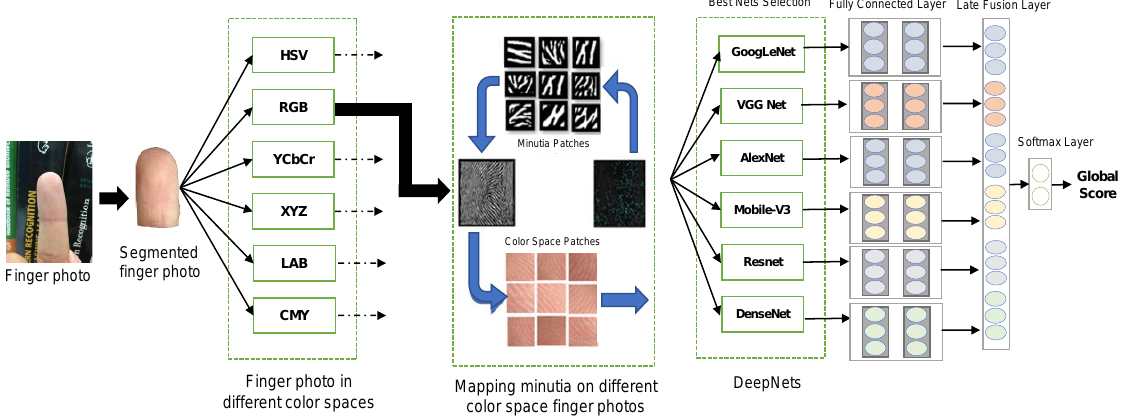
Figure 3. The finger photo is segmented with respect to the distal phalange and transformed to different color spaces. Patches centered around minutiae points are determined and used to feed different CNNs. Deep fusion is performed on the best-selected color models and an overall global decision is